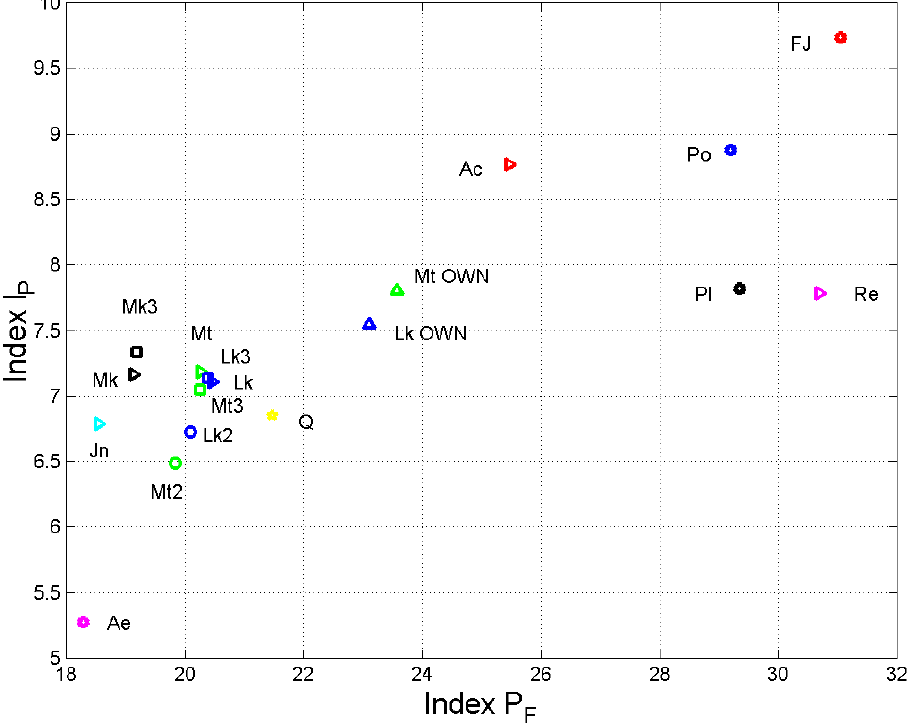
Figure 17. Average number of words per interpunctions, 𝐼 𝑃 , versus the average number of words per sentence, 𝑃 𝐹 . Triangles with vertex to the right refer to Full Texts. Squares refer to the Triple Tradition (e.g., Mt3). Circles refer to the Double Tradition (e.g., Mt2). Triangles with vertex up refer to the Own Tradition. Matthew : green; Mark : black; Luke : blue; John : cyan; Acts: red; Revelation : magenta; Q : yellow. Aesop (Ae): magenta star; Polybius (Po): blue star; Plutarch (Pl): black star; Flavius Josephus (FJ): red star.